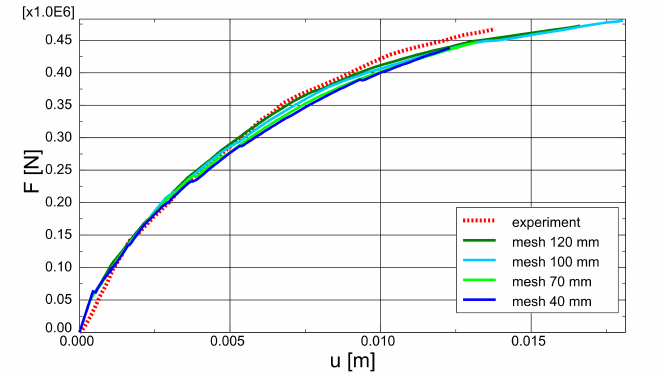
Figure 28. A-1 beam—mesh dependency